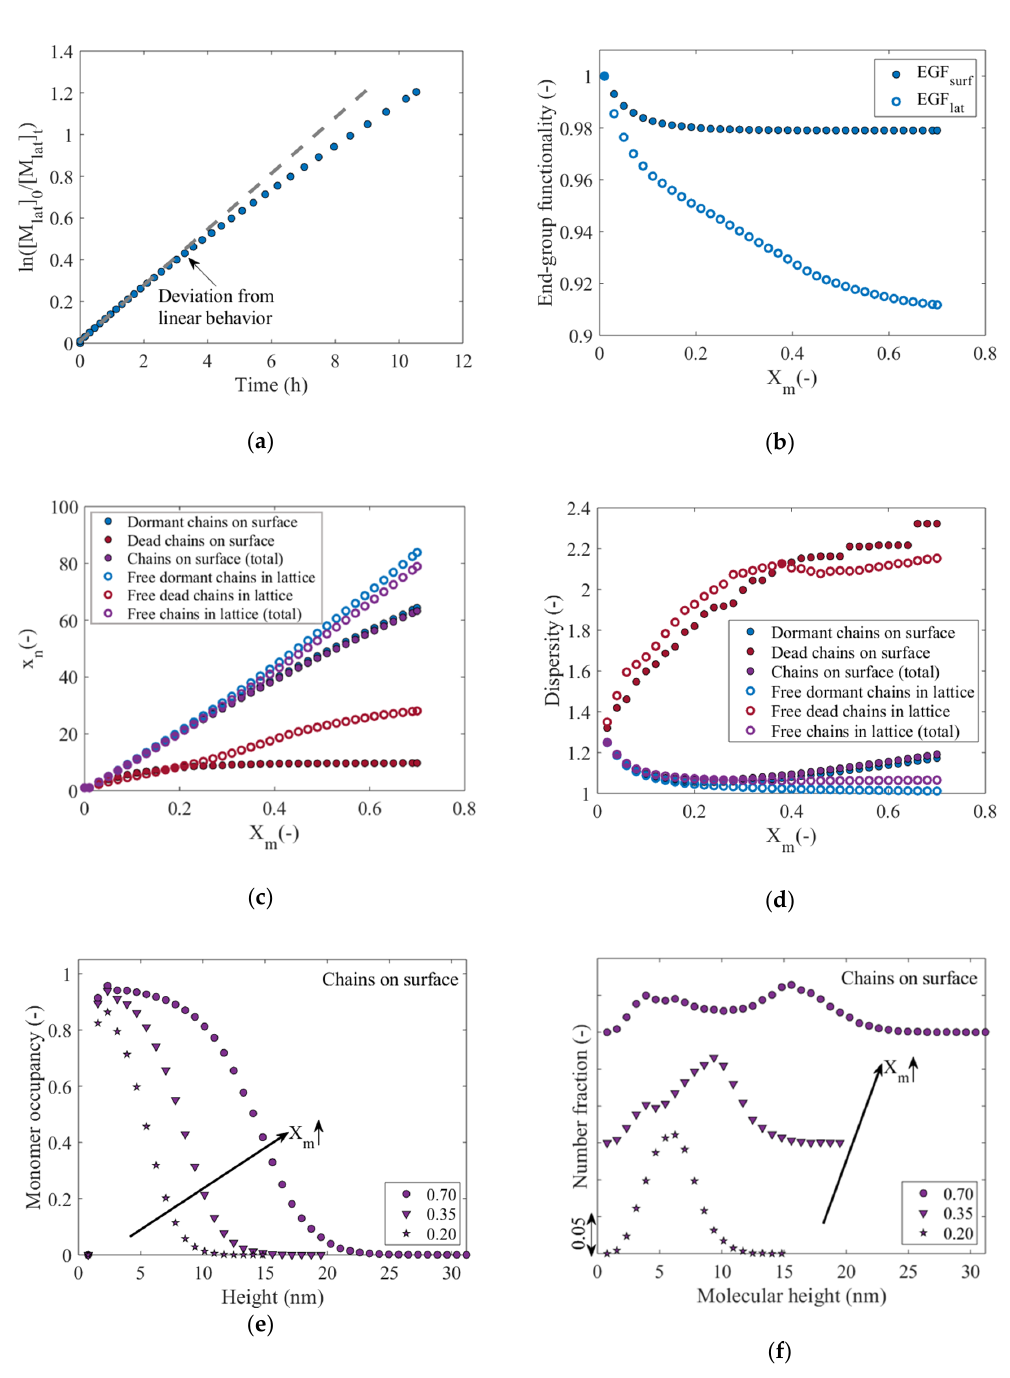
Figure 4. ( a ) Evolution of ln ([ M / [ M lat ] ) vs time under reference surface-initiated reversible deactivation radical polymerization (SI-RDRP) conditions (translational mode). Corresponding ( b ) end-group functionality (EGF) on surface (black-contoured full blue circles; EGF surf ) and free dormant chains in solution near the surface (blue-contoured empty circles; EGF lat ) as a function of monomer conversion ( X m ). ( c ) Number average chain length ( x n ) and ( d ) dispersity for dormant (blue symbols) and dead chains (red symbols) as well as the total values (purple) on surface (full symbols) or in solution (empty symbols) as a function of X m . ( e ) Monomer occupancy along the lattice height (z direction) in nm at 3 X m values and ( f ) molecular height distribution (MHD) at three X m values. Simulation = 1 × 10 5 , target chain length (TCL) = N conditions: amount of RDRP initiator molecules N R R 0, surf X 0, lat X of 100 in both phases (initial number of monomer molecules N M = 2 × 10 7 ) and average surface coverage θ = 2.5 × 10 − 1 ; kinetic parameters in Table R 0, sur X